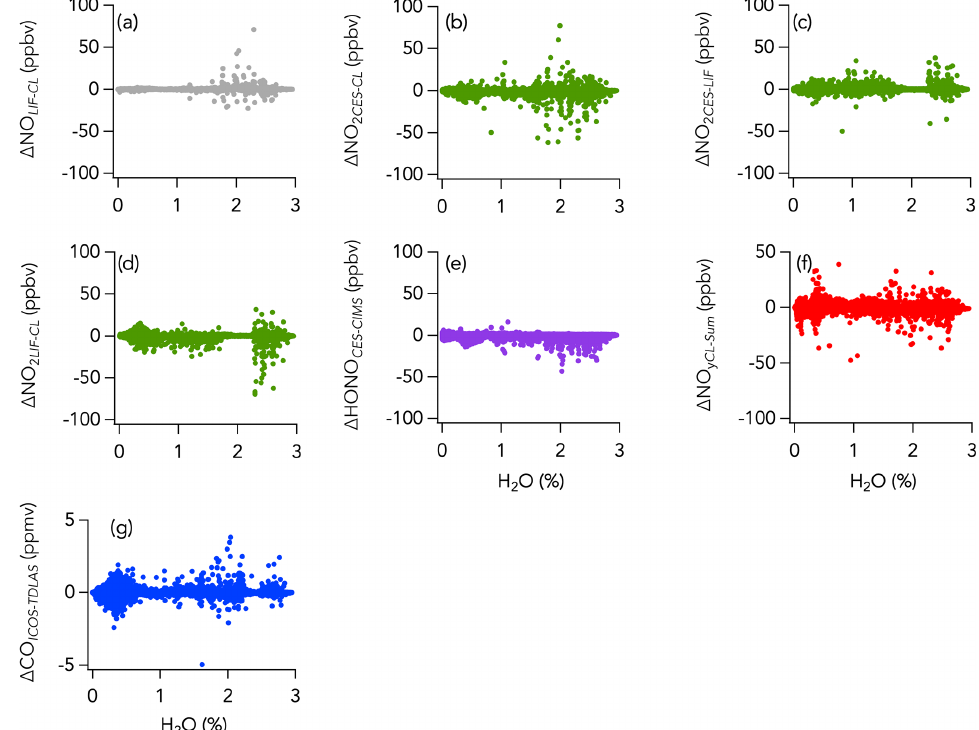
Figure 6. Measurement difference (1s data) for (a) NO, (b–d) NO 2 , (e) HONO, (f) NO y , and (g) CO as a function of water vapor for the entire